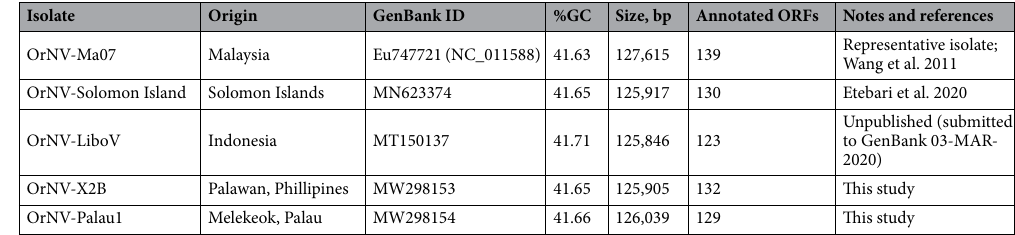
Table 2. Isolates of Oryctes rhinoceros nudivirus (OrNV) with completely sequenced genomes.